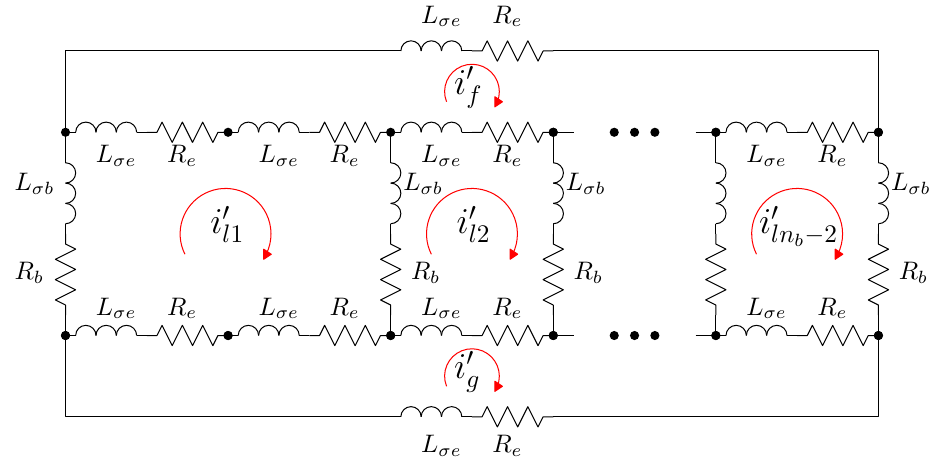
Figure 8. Rotor loops in a squirrel cage rotor of n b bars with two non-consecutive broken bars ( b